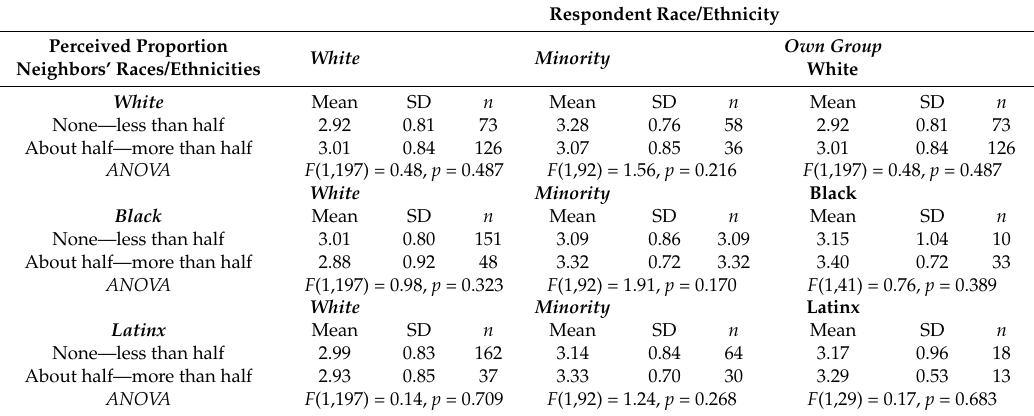
Table A3. Support for social policies (Index 2) by perceived neighborhood ethnic composition and respondent